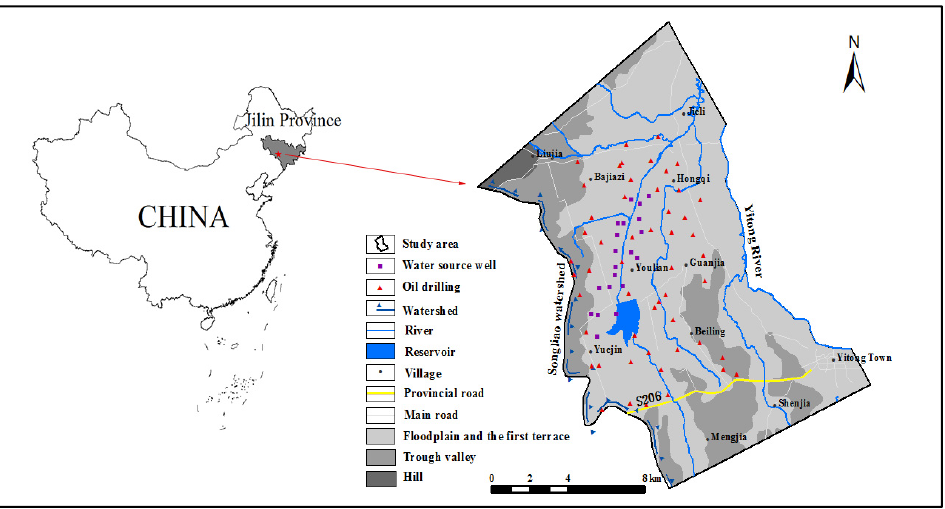
Figure 1. Location of study area and distribution of water source wells and designed oil drilling wells.